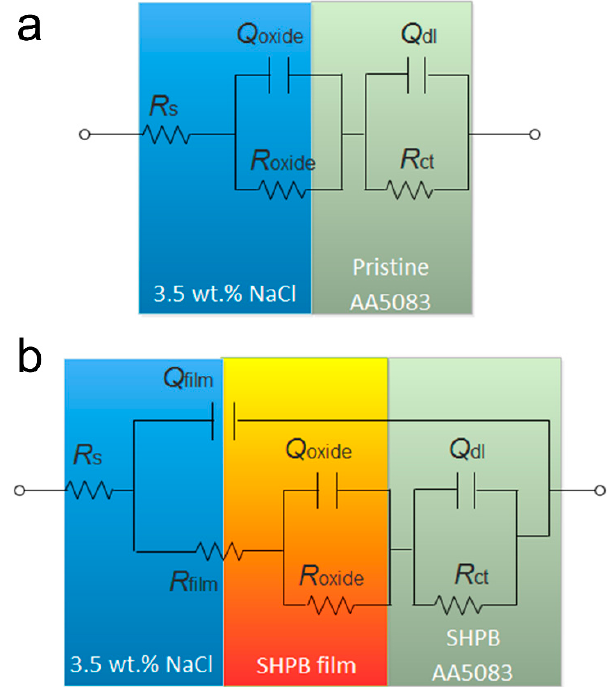
Figure 8. Equivalent circuit of ( a ) pristine AA5083 and ( b ) superhydrophobic AA5083.